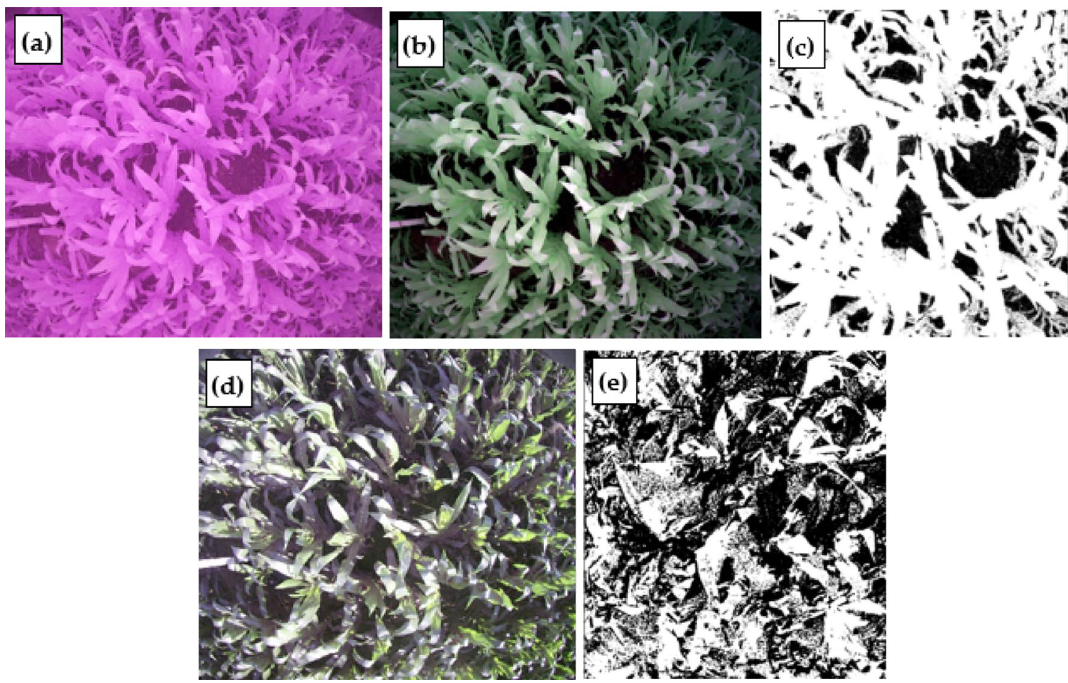
Figure 5. Original images and binary images of site 1 on July 1: ( a ) the original image at 1:30 p.m.; ( b ) preprocessing result of image ( a ); ( c ) the binary image of ( a ); ( d ) original image at 6:30 p.m.; ( e ) binary image of ( d